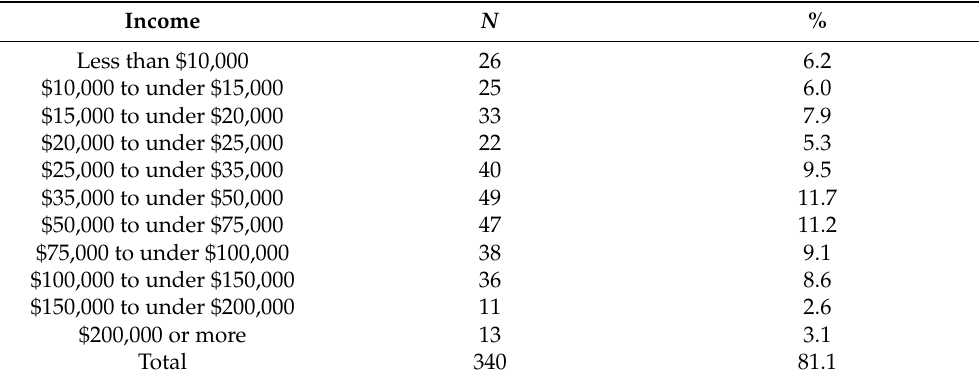
Table 2. Household